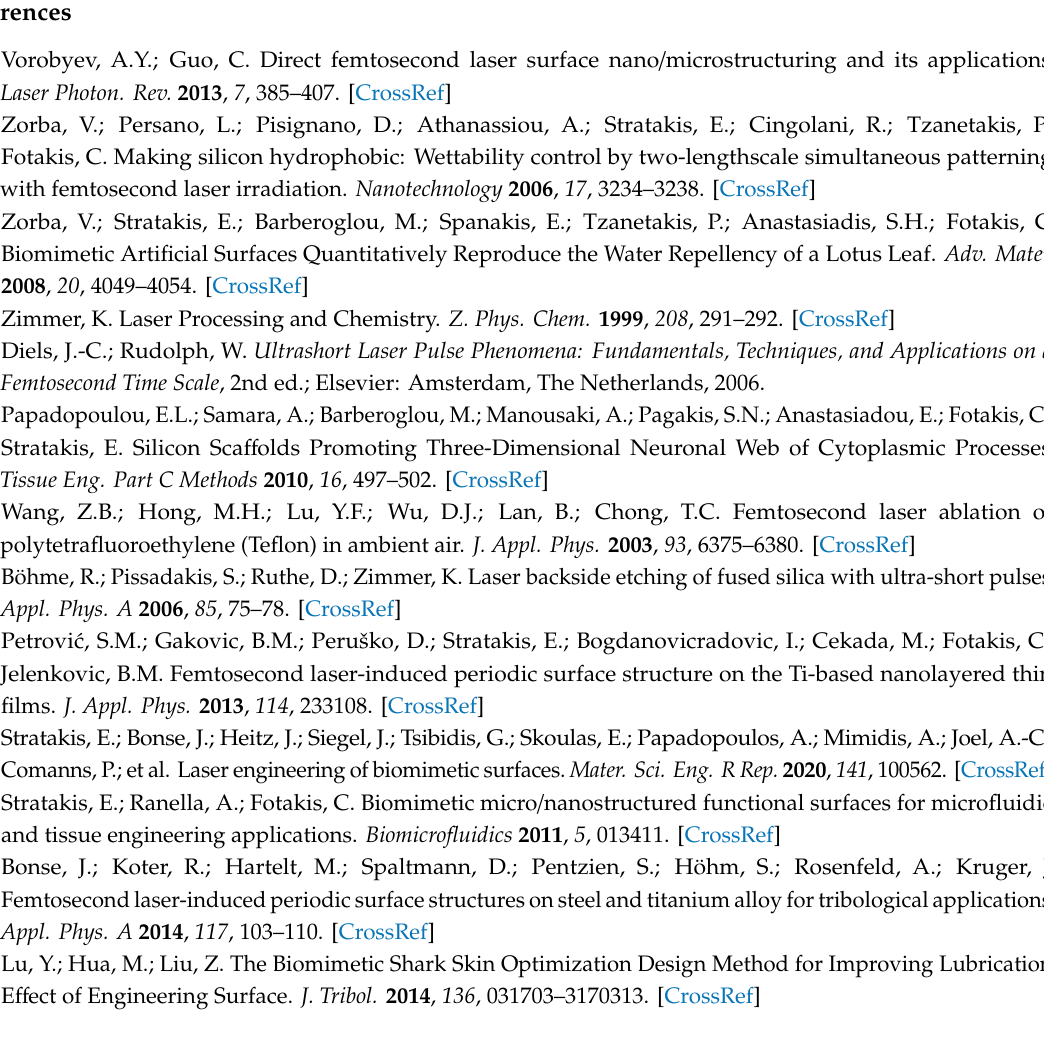
Figure A3. SEM images of surface structures on (100) rutile TiO2 obtained after laser irradiation (248 nm, 450 ps, NP = 100) with total measured fluence of 300 mJ/cm² and delay between pulses of 4 ps ( a ) and 10 ps ( b ). The double-headed arrow indicates the direction of laser polarization.